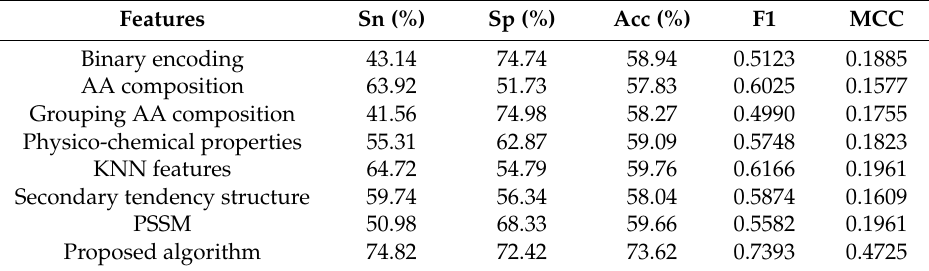
Table 3. Performances of different features in H. sapiens